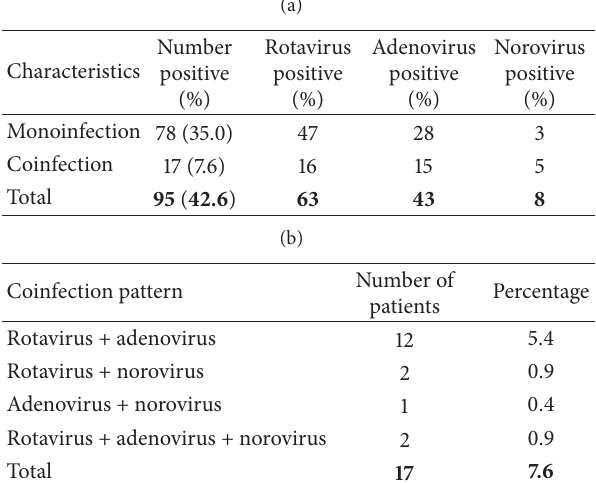
Table 3: Monoinfection, coinfection, and pattern of coinfection of enteric